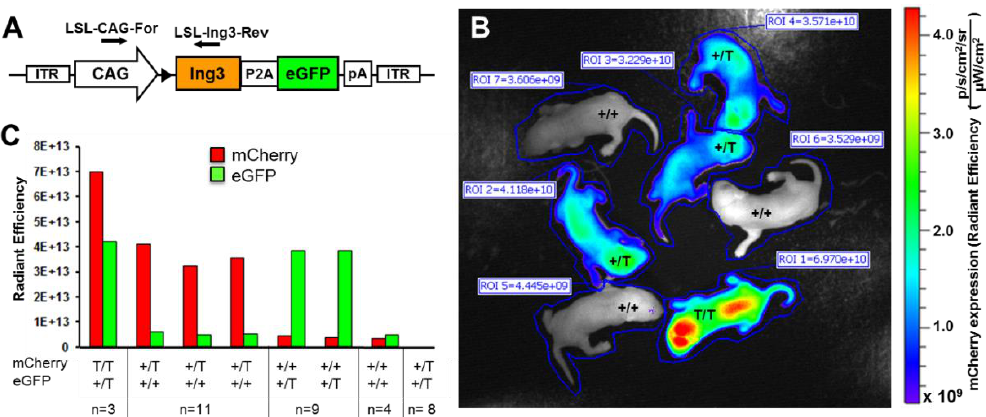
Figure 4. Reconstitution of ING3 by ubiquitous expression of Ing3-P2A-eGFP. ( A ) Schematic view of the Ing3 transposon construct. ( B ) In vivo imaging showing mCherry expression of different genotypes in a representative litter of a UbC-mCherry, CAG-Ing3-P2A-eGFP double mutant bred to a hemizygous UbC-mCherry mouse. ( C ) mCherry and eGFP expression with corresponding genotypes of UbC-mCherry and CAG-Ing3-P2A-eGFP transgenic pups (homozygous (T/T), hemizyous (+/T) and wild type (+/+)). Total numbers of animals per genotype are indicated in the figure. Position of genotyping primers are indicated by arrows.